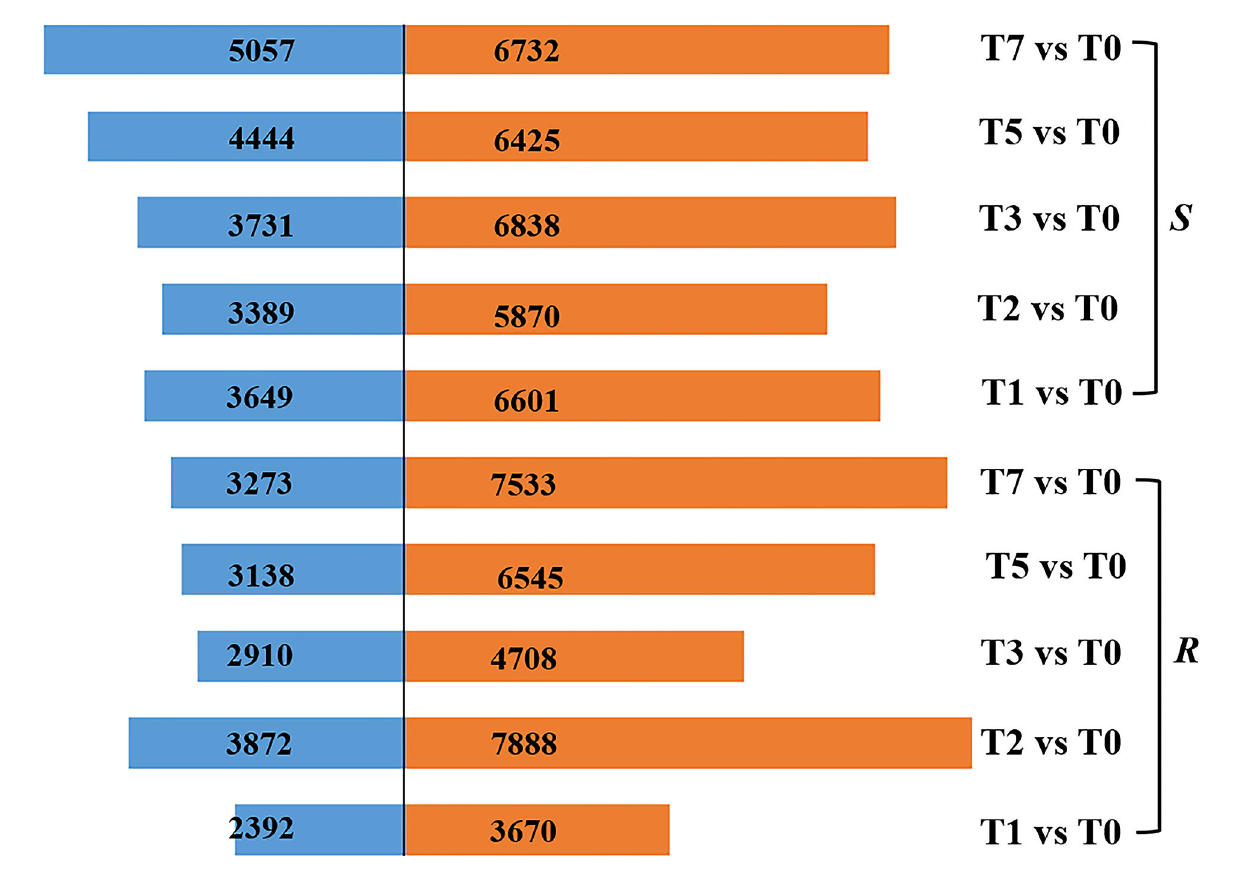
implying the high accuracy of transcriptome sequencing results ( Supplementary Figure S1 ). Pearson correlation coefficients among samples ( Supplementary Figure S2 ) and principal ( Supplementary Figure S3